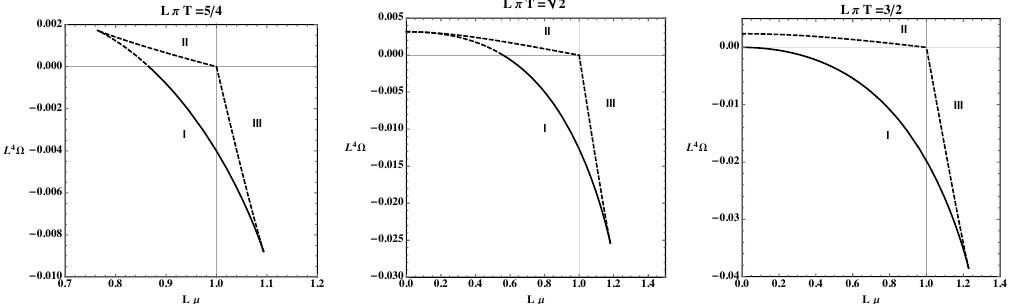
Figure 10 . Grand canonical potential as function of the chemical potential for di(cid:11)erent values of the temperature. Dashed curves correspond to unstable or metastable phases. The branches with larger values of (cid:10) correspond to the unstable phases, II and III , while the lower branch ( I ) is metastable until it reaches (cid:10) = 0, which corresponds to the Hawking-Page transition. Susceptibilities diverge at the point where the two symmetric branches touch. At high enough temperatures, L(cid:25)T > 3 = 2, the Hawking-Page transition goes away and the stable black hole phase dominates at low values of the chemical potential. In all cases, at large enough values of the chemical potential, the black hole phases